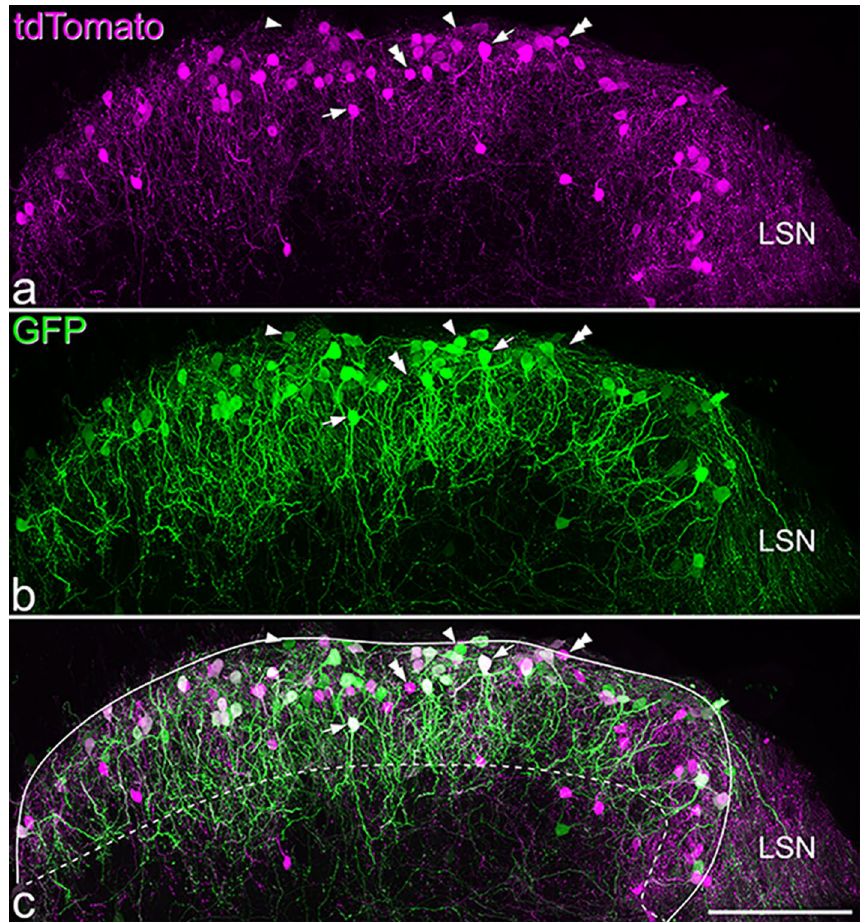
Figure 2. The distribution of tdTomato- and GFP-labelled cells in the L3 segment of the spinal cord of a NPFF Cre ;Ai9 mouse that had received intraspinal injections of AAV.flex.GFP. a and b show that both tdTomato- and GFP-positive cells are largely restricted to the superficial dorsal horn. c : the merged image reveals that many cells contain both fluorescent proteins (some indicated with arrows), while some cells are positive for only GFP or tdTomato (some of these are marked with single or double arrowheads, respectively). Dendritic labelling is more prominent in the GFP image, and dendrites of these cells commonly project ventrally into the deeper regions of the dorsal horn. Some labelling with each fluorescent protein is seen in the lateral spinal nucleus (LSN), but labelled cell bodies are seldom seen here. We found that 48% of labelled cells contained both fluorescent proteins, 30% only contained GFP and 22% contained only tdTomato. The solid and dashed lines in c indicate the edge of the grey matter and the approximate border between laminae II and III, respectively. Images are projections of 58 optical sections at 1 μm z-separation. Scale bar = 100